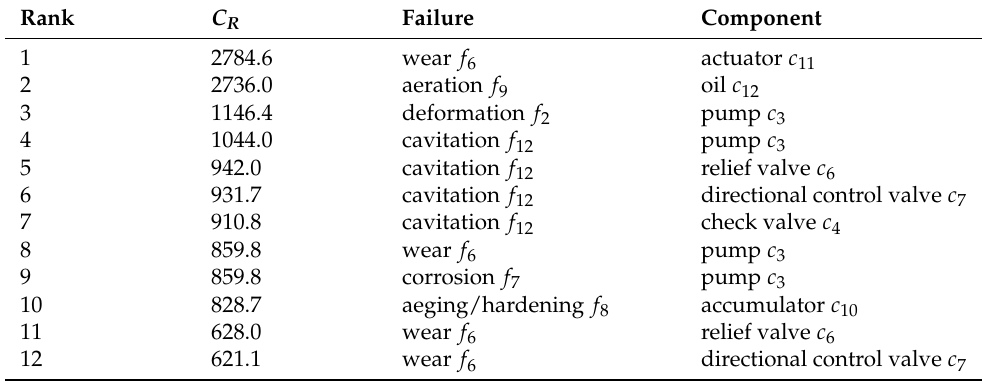
Table 6. Functional failures f f 3 .